Question: Write a single sentence explaining what this figure depicts.
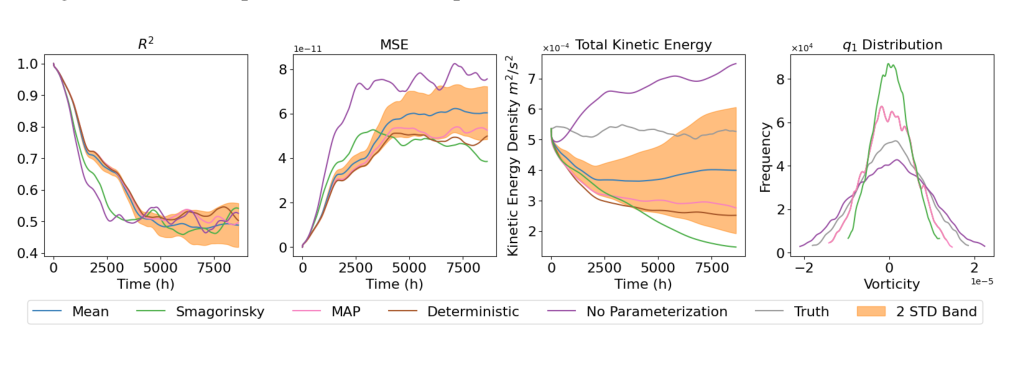
Answer: Metrics evaluating the performance of online predictions over 1 year period.